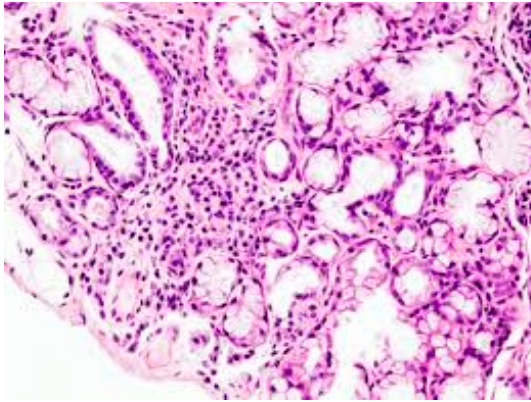
Figure 1. Lymphocyte infiltration in primary Sjogren’s syndrome (pSS) xerostomia (biopsy). (The tissue was coloured with Toleudine blue 0.1% then was analysed under optical miscroscopy magnification ×10). Pathogenic viruses are potential biological elements that can trigger a number of diseases